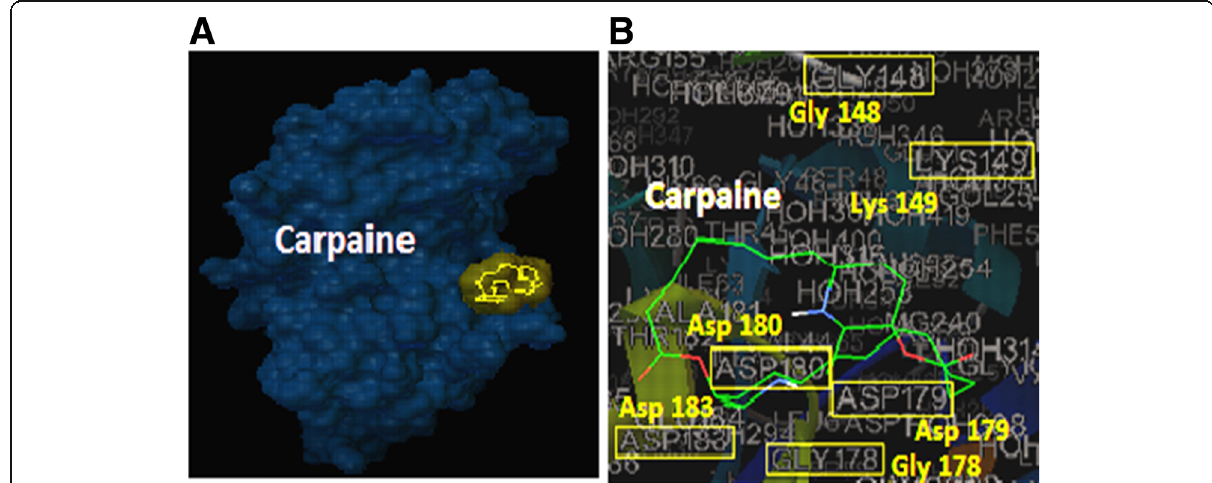
Fig. 6 a , b Docking pose of model TPP with phytochemical